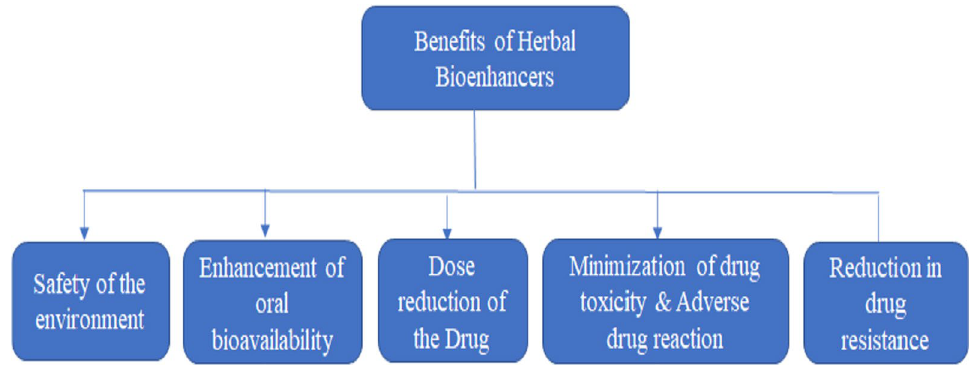
Fig. 1 Benefits of herbal